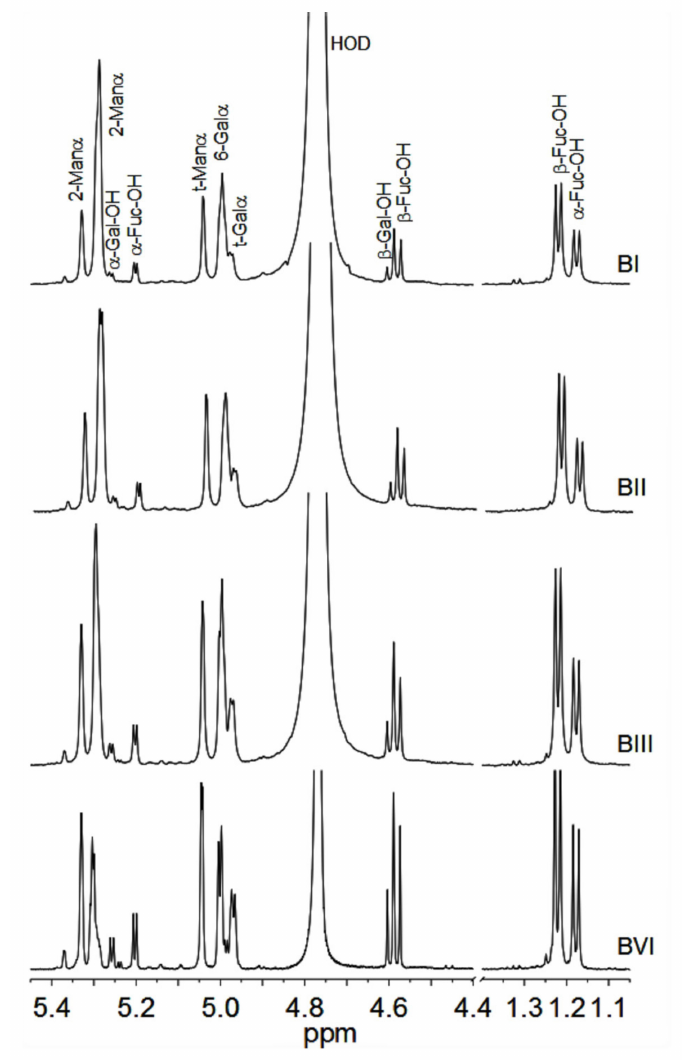
Figure 5. Anomeric and methyl regions of the 1 H NMR spectra of samples BI, BII, BIII, and BIV. Assignment of main signals is